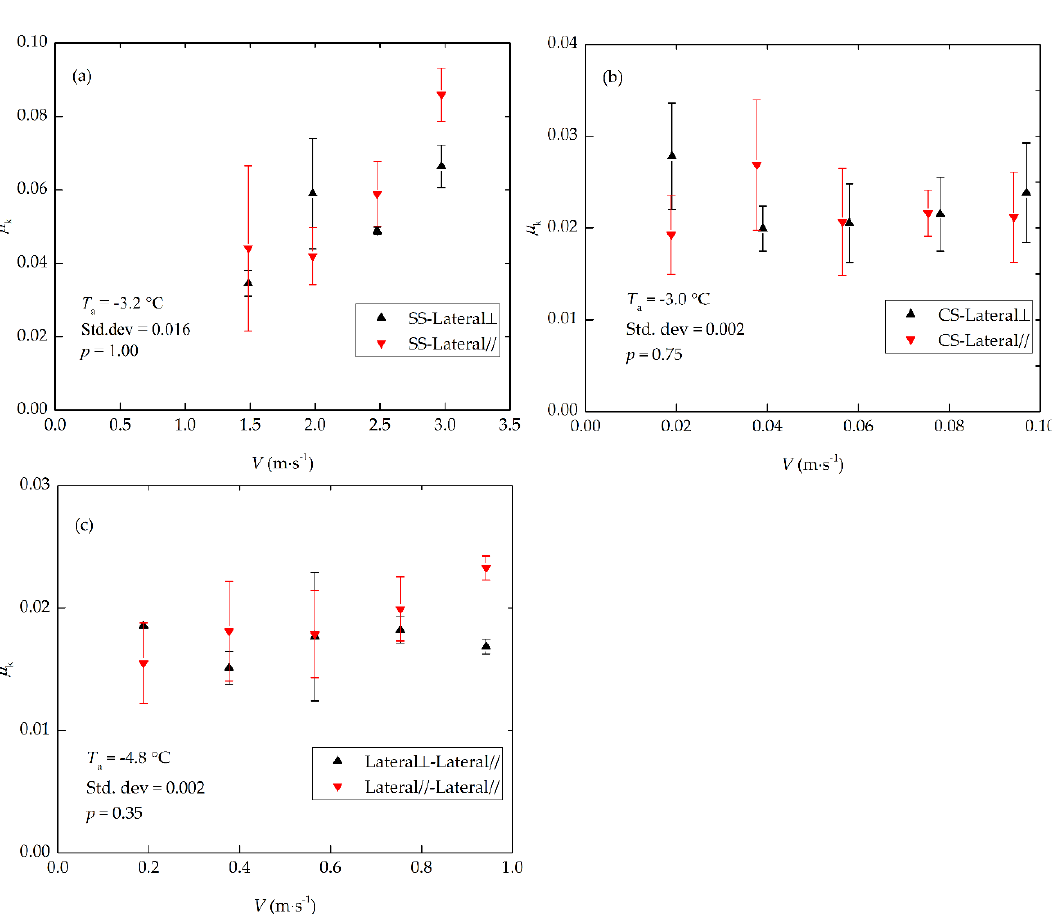
Figure 8. Variations of μ k with velocity V of friction for ( a ) SS, ( b ) CS, and ( c ) sea ice sliders in directions parallel and vertical to ice columnar grain orientation. The data were averaged over the normal stresses, and the error bars represent the standard deviation. Also shown are the test air temperature, the standard deviations of both datasets, and the significance coefficients of the rank sum tests.